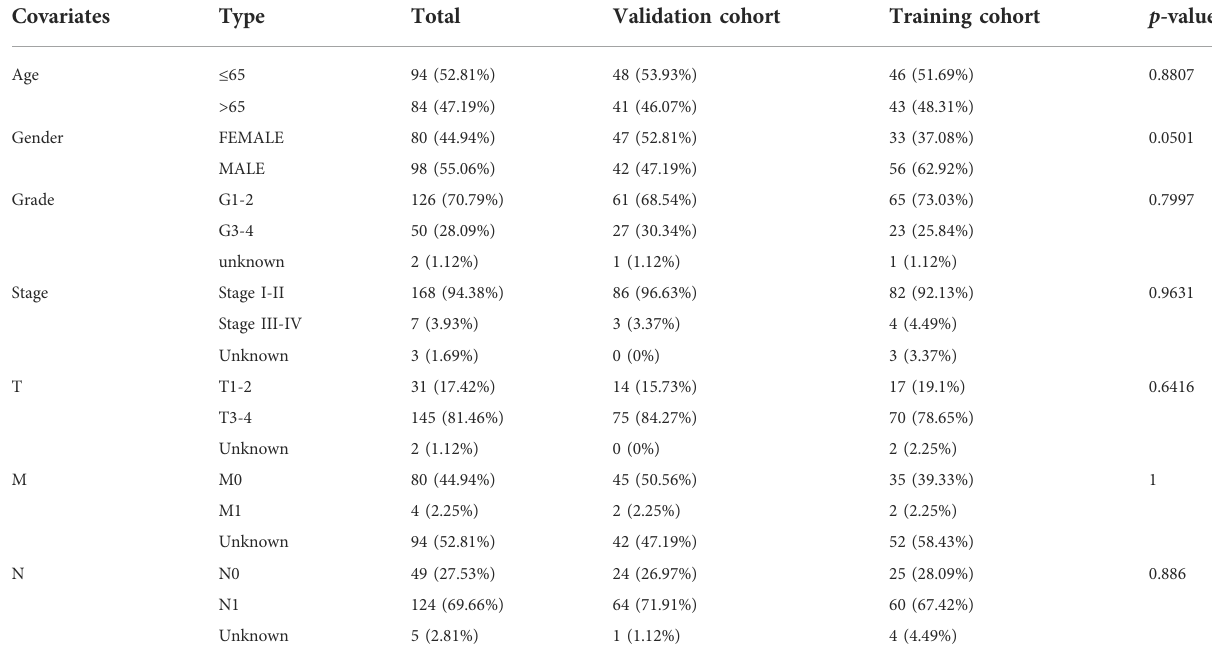
TABLE 1 Comparison of clinicopathological features between the validation and training